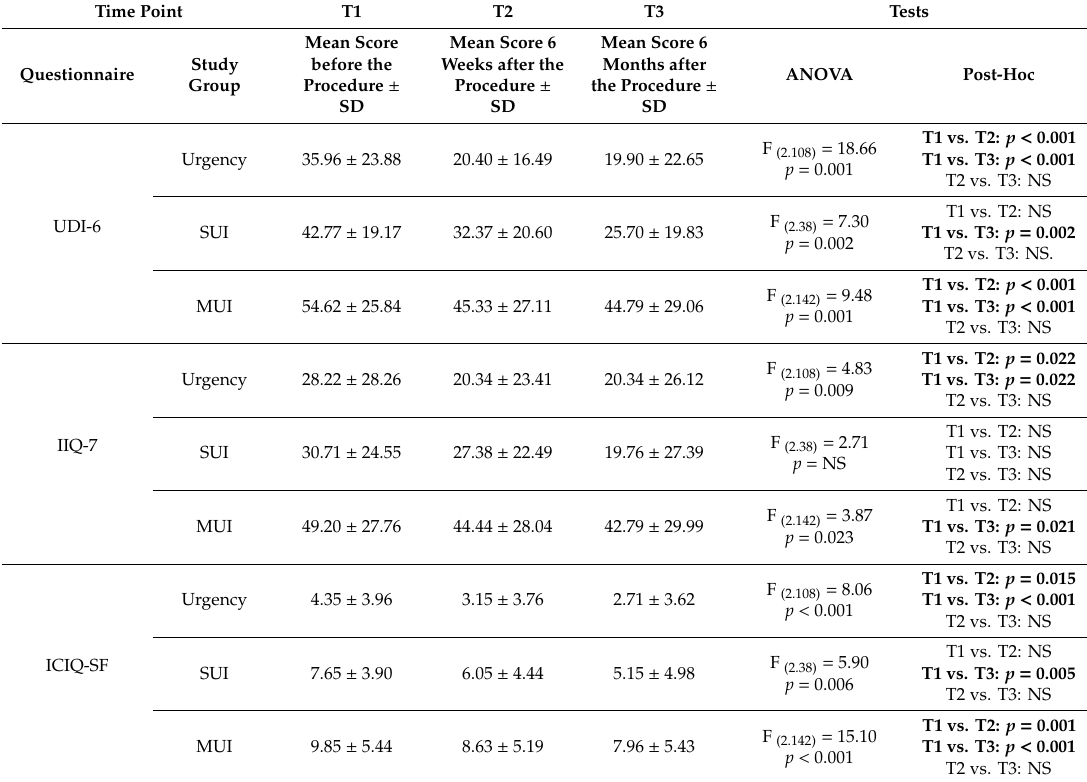
Table 6. Mean results of Urogenital Distress Inventory-6 (UDI-6), Incontinence Impact Questionnaire-7 (IIQ-7), and the International Consultation on Incontinence Questionnaire-Short Form (ICIQ-SF) among patients from the study